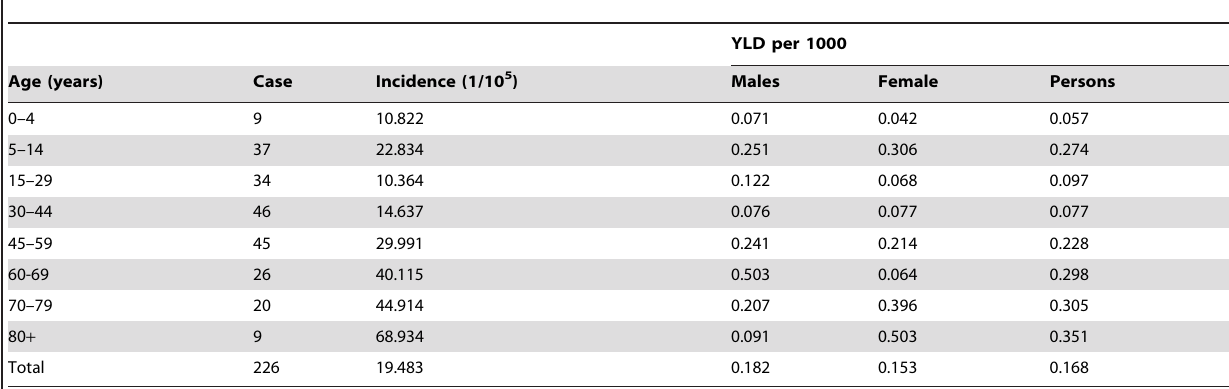
Table 4. The epidemiological burden of malaria caused by flooding and waterlogging together during exposure common effect- period for both flooding and